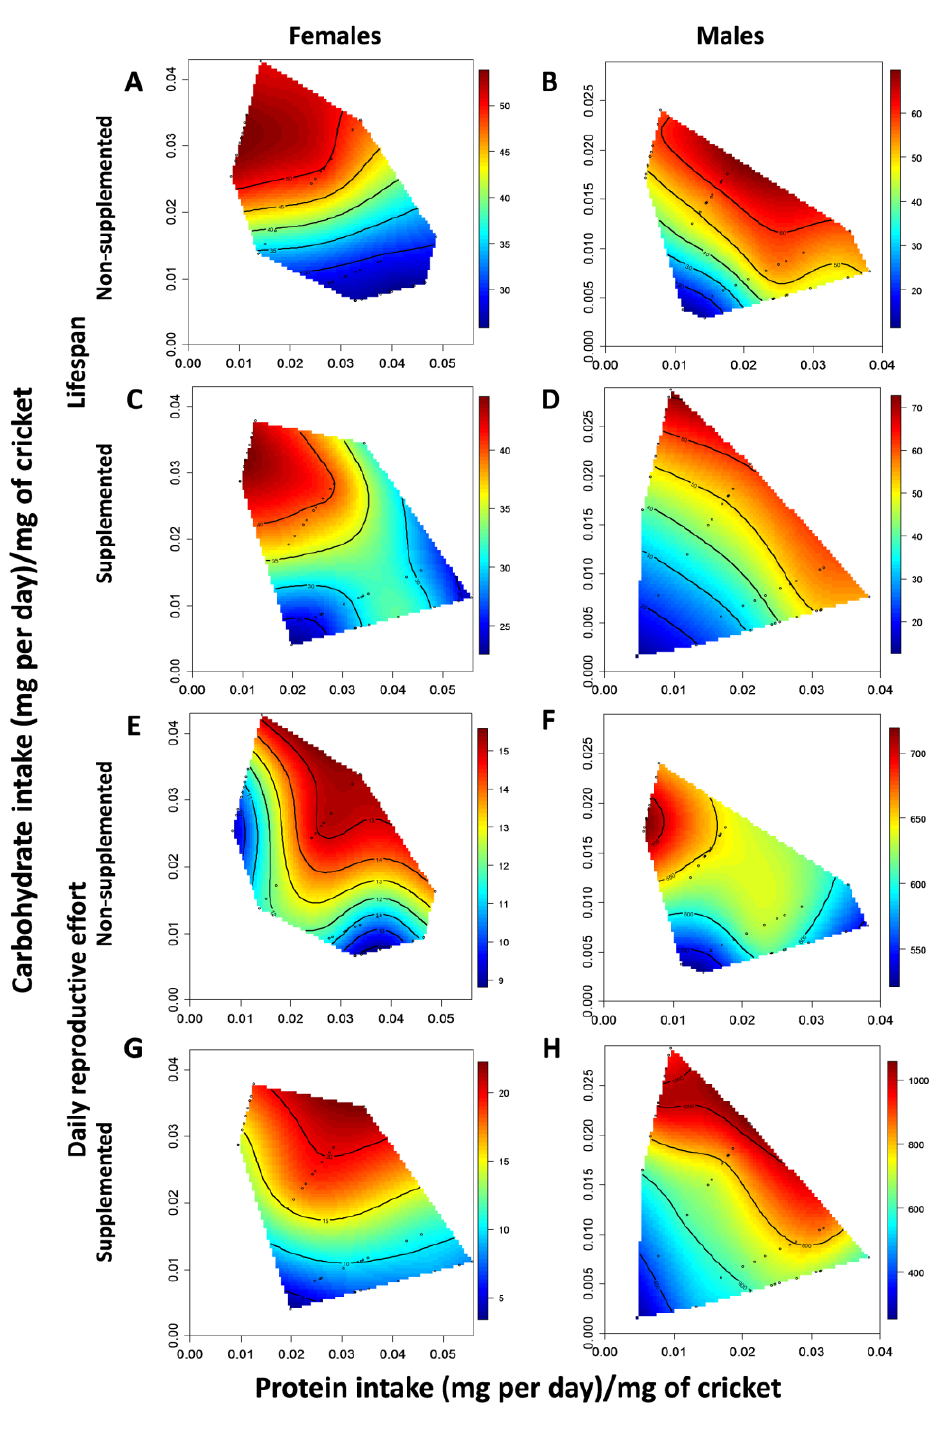
Figure 1. Nutritional landscapes illustrating the effects of daily protein and carbohydrate intake on lifespan ( A – D ) and daily reproductive effort ( E – H ) in female ( A , C , E , G ) and male ( B , D , F , H ) crickets that were supplemented with DL-alpha-tocopherol ( C , D , G , H ) or not ( A , B , E , F ). High values of these traits are in red and low values in blue. The scale associated with each graph is shown to its right: the values for each scale bar are days (for lifespan), daily number of eggs laid (female reproductive effort) or time spent calling (male reproductive effort). Black dots represent the actual intake of nutrients by individual